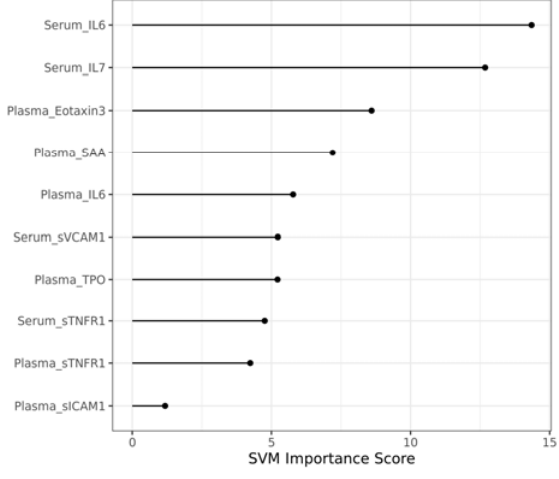
Figure 3. Importance score for selected 10 serum and plasma biomarker combination in the 10 times repeated 5-fold cross-validation model.